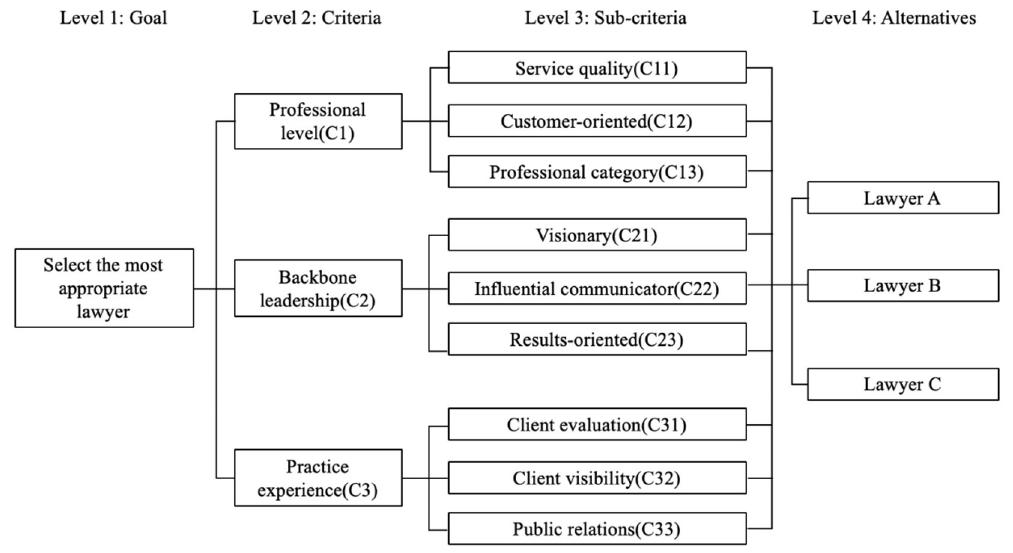
Figure 2. Framework for evaluating lawyer selection.